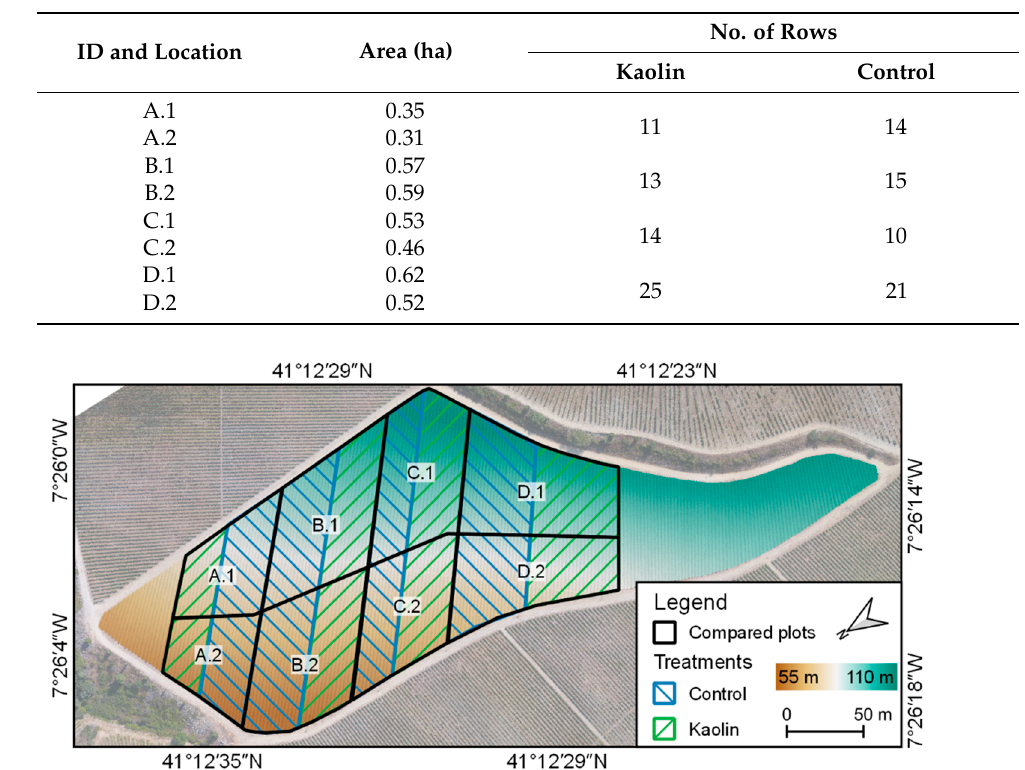
Table 2. Area and number of rows used for comparing treatment plots.